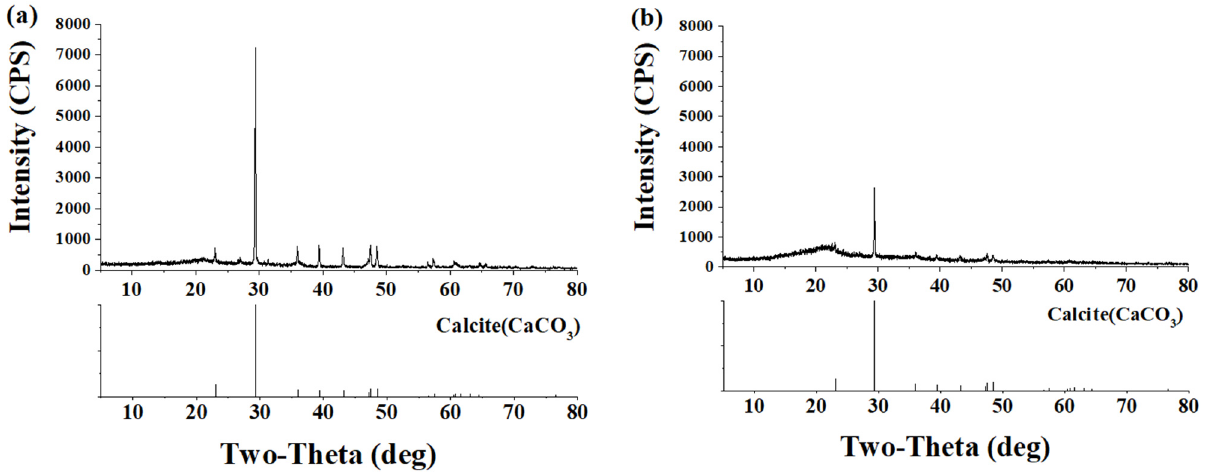
Figure 7. XRD result of collected crystalline over surface of BPM ( a ) and BM ( b ) specimen.